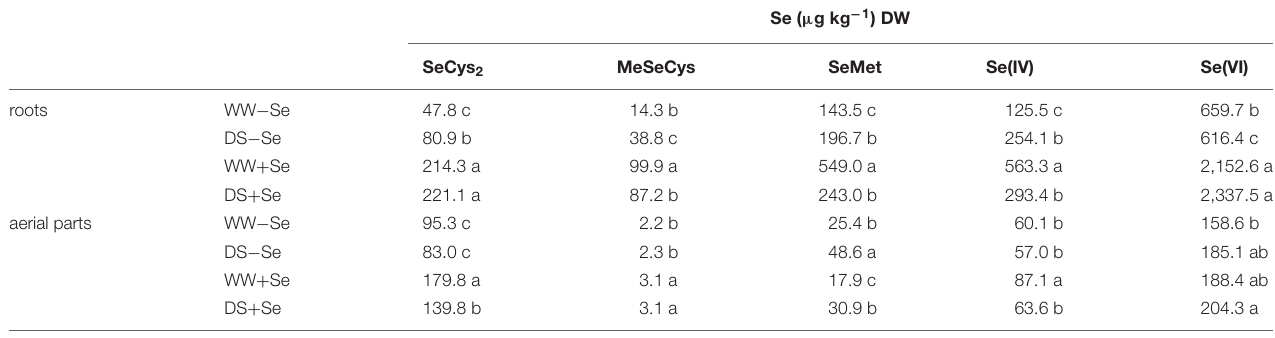
TABLE 3 | Selenium speciation in maize aerial parts and roots.